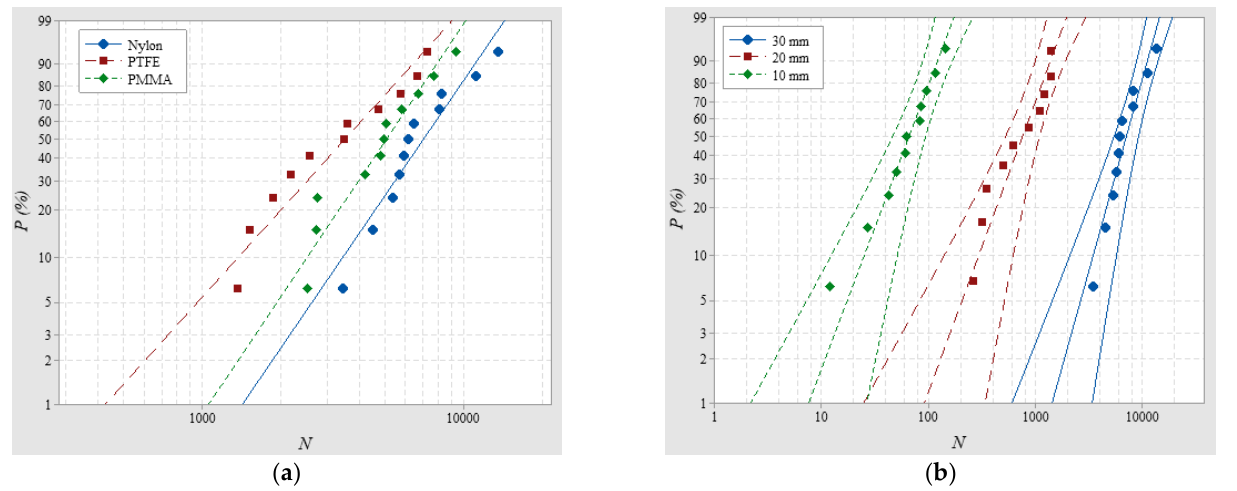
Figure 5. SILs vary with ( a ) different materials and ( b ) different thicknesses.